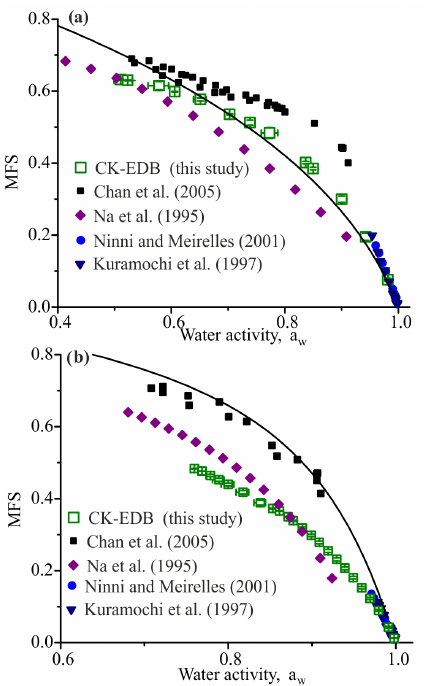
Figure 10. Equilibrium hygroscopicity curves for sugars and al- cohols with the same O:C ratio of 1. UNIFAC prediction using